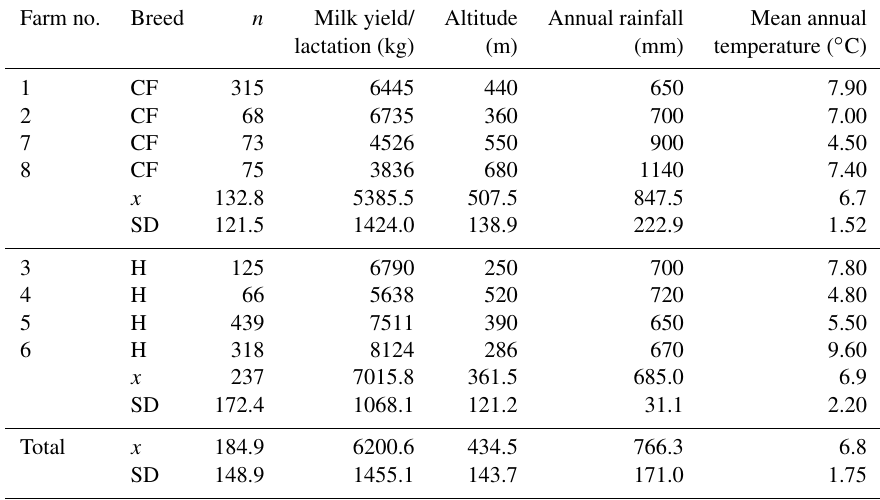
Table 1. Basic information about environment of studied dairy cow herds. Farm no. Breed n Milk yield/ Altitude Annual rainfall Mean annual lactation (kg) (m) (mm) temperature ( ◦ C) 1 CF 315 6445 440 650